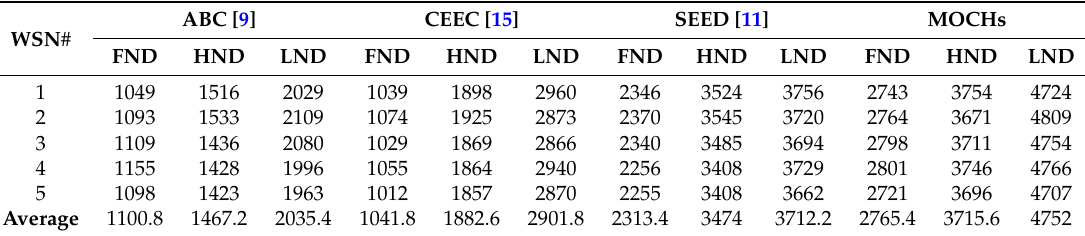
Table 3. Network lifetime over simulations of five WSNs (with 300